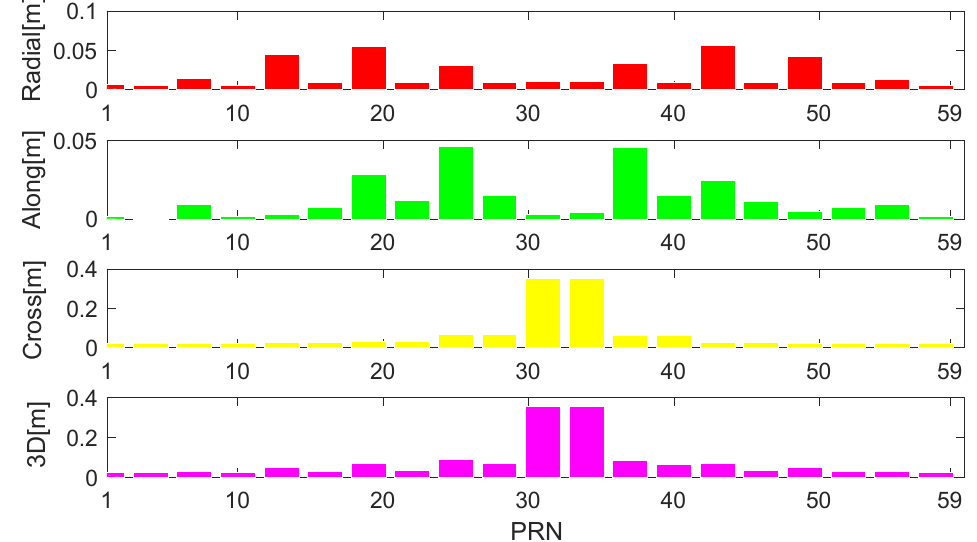
Figure 7. 60-LEO constellation orbital errors in radial, along-track, cross-track, and 3D under 20 cm ranging accuracy, in which satellite of PRN 1, 4, 7, ... , 58 (divided at interval 3 of PRN number) are displayed.